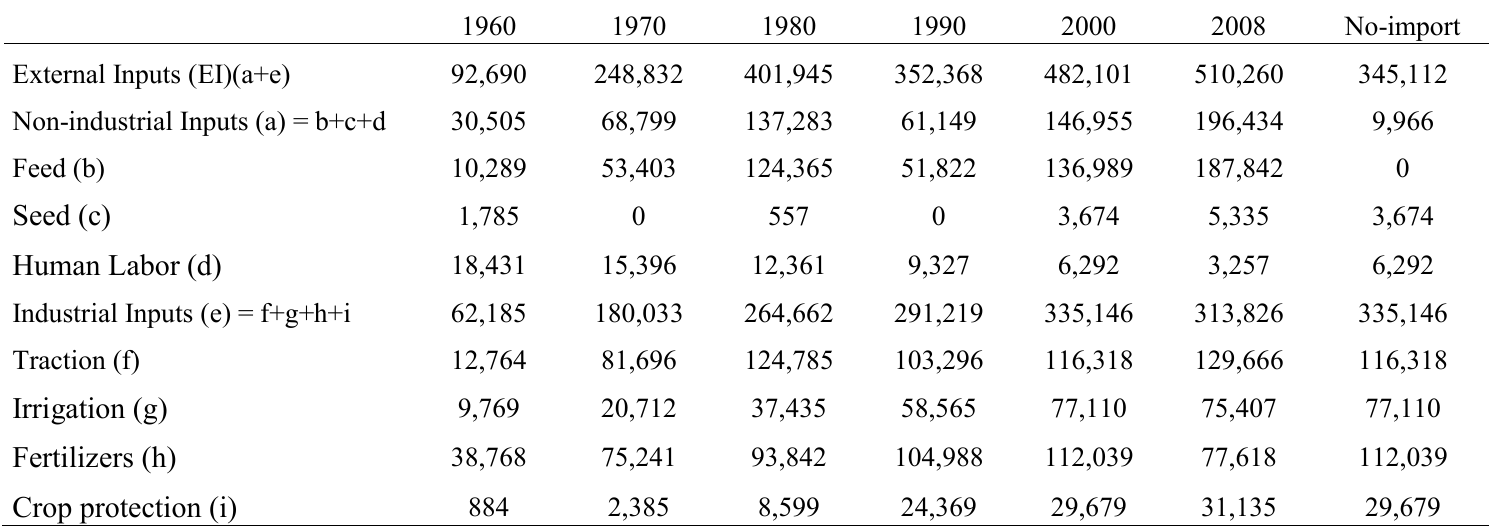
Table A1.2. External inputs evolution (TJ),